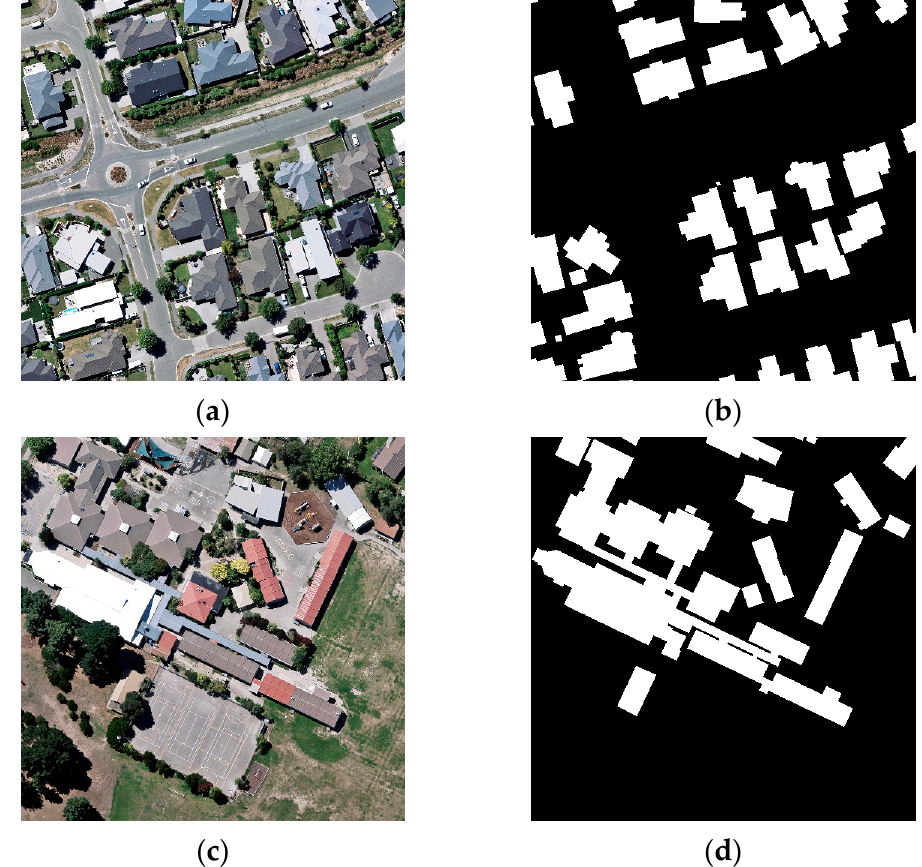
Figure 6. Original image and label. ( a ) Image 1; ( b ) Label 1; ( c ) Image 2; ( d ) Label 2.